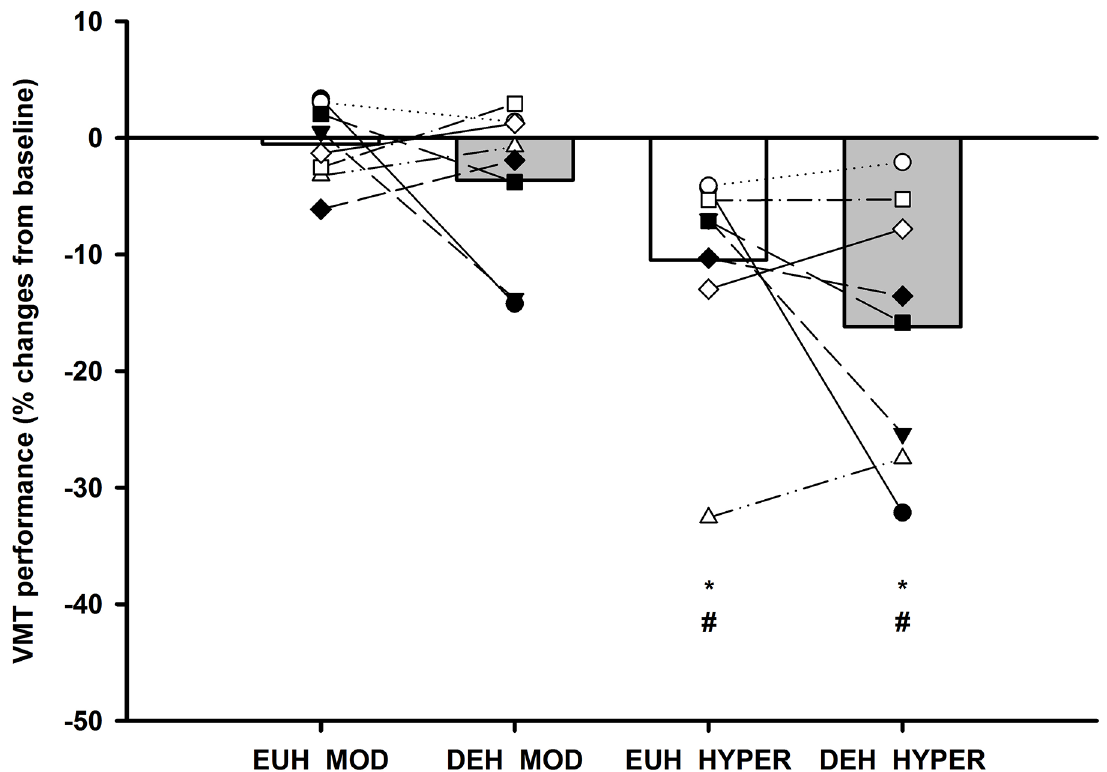
Fig 6. VMT performance score. Performance scores in the visuo-motor tracking (VMT) during euhydration (EUH: MOD and HYPER [White bars]) and dehydration (DEH: MOD and HYPER [Grey bars]). Values are expressed in percentage change from BASELINE (BASELINE expressed as 0) and individual participant changes in each condition and session. (cid:3) Significantly different from BASELINE and # significantly different from MOD, (P < 0 . 05) .